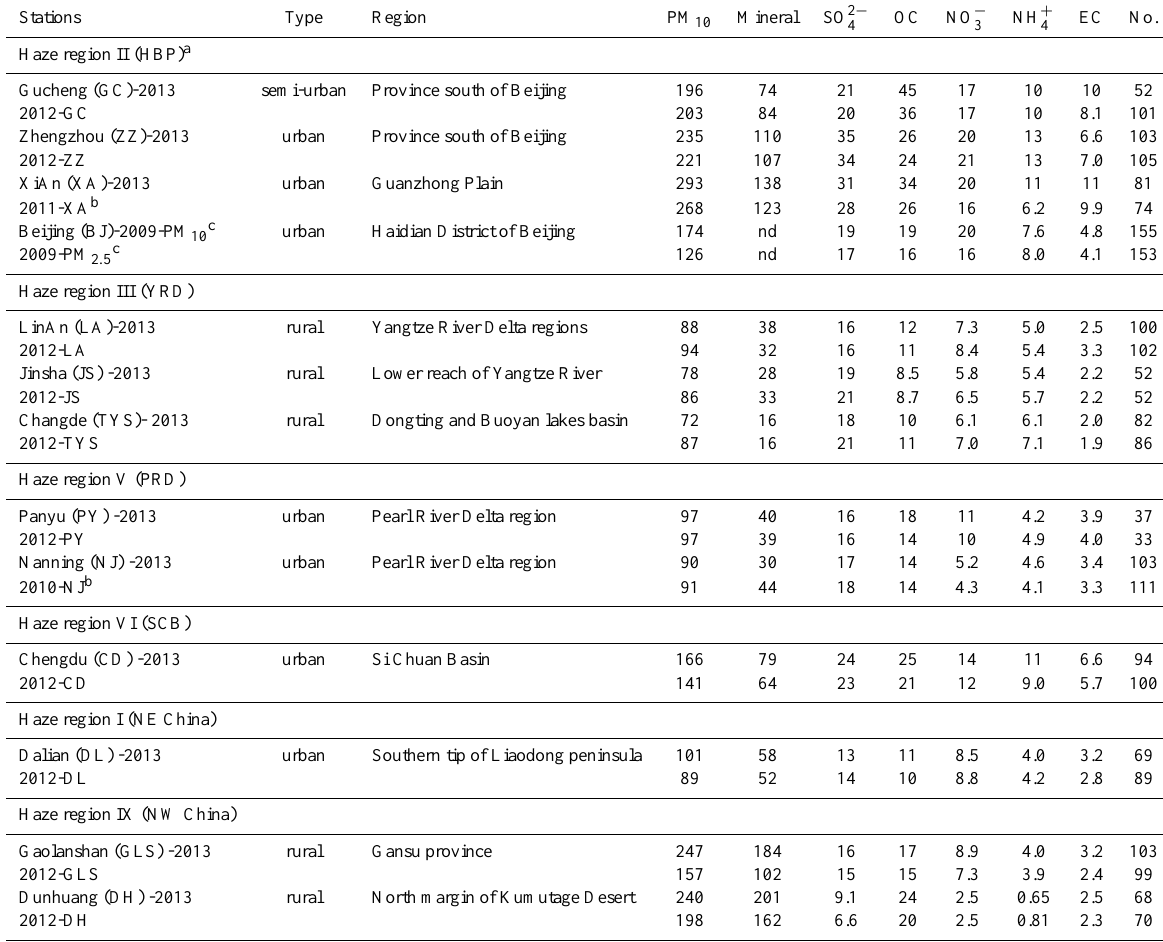
a ClassificationofmajorhazeregionsaretakenfromX.Y.Zhangetal.(2012); b AtXiAnandNanjing,datain2011and2010,respectively,areusedhereforcomparisonwith2013results; c Beijingis2009datafor PM 10 and PM 2 . 5